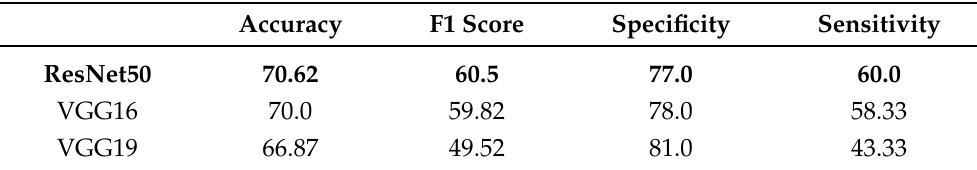
Table 3. Result of various pre-trained models trained with the left oblique view.